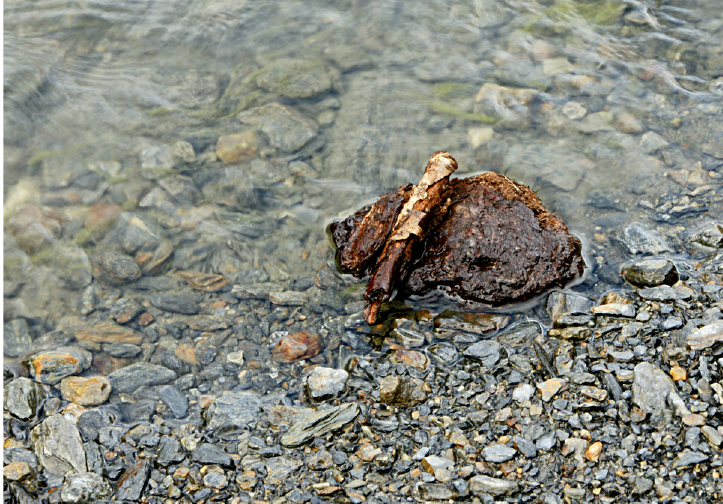
Figure 36: Kårsajökeln (8). Compressed peat cake, 3285 cal. yr BP (Beta-268656), with an attached birch twig (not dated), drifting in a melt water